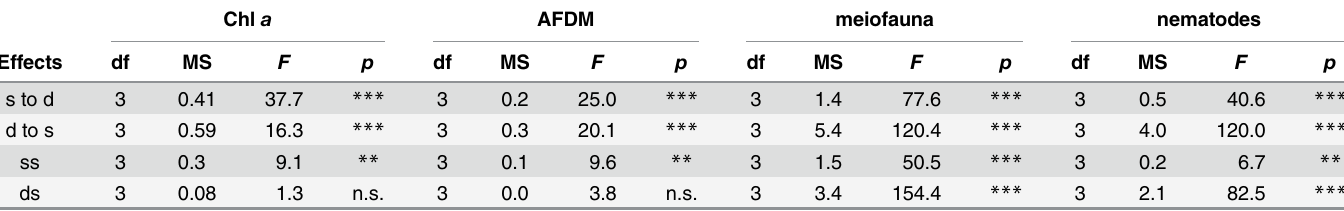
Cross-over and shaded treatments (shallow-to-deep: s to d, deep-to-shallow: d to s, shallow-shaded: ss, and deep-shaded: ds) were set as independent factors with four temporal modalities. Signi fi cance level ( p ): n.s.: not signi fi